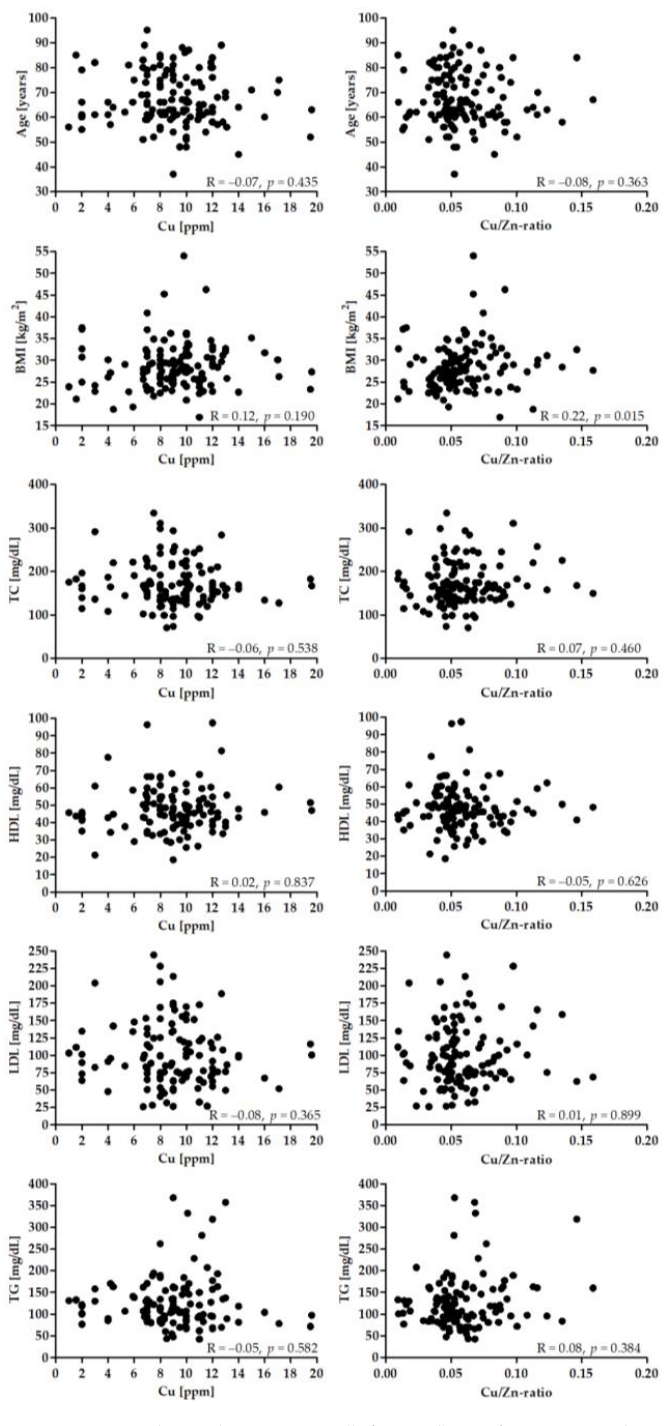
Figure 2. Correlation between Cu (left panel), Cu/Zn-ratio and age, BMI and lipid profile.